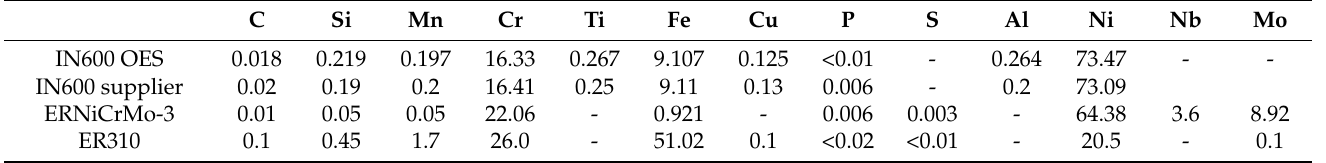
Table 1. The chemical compositions of the IN600 plates and filler wires